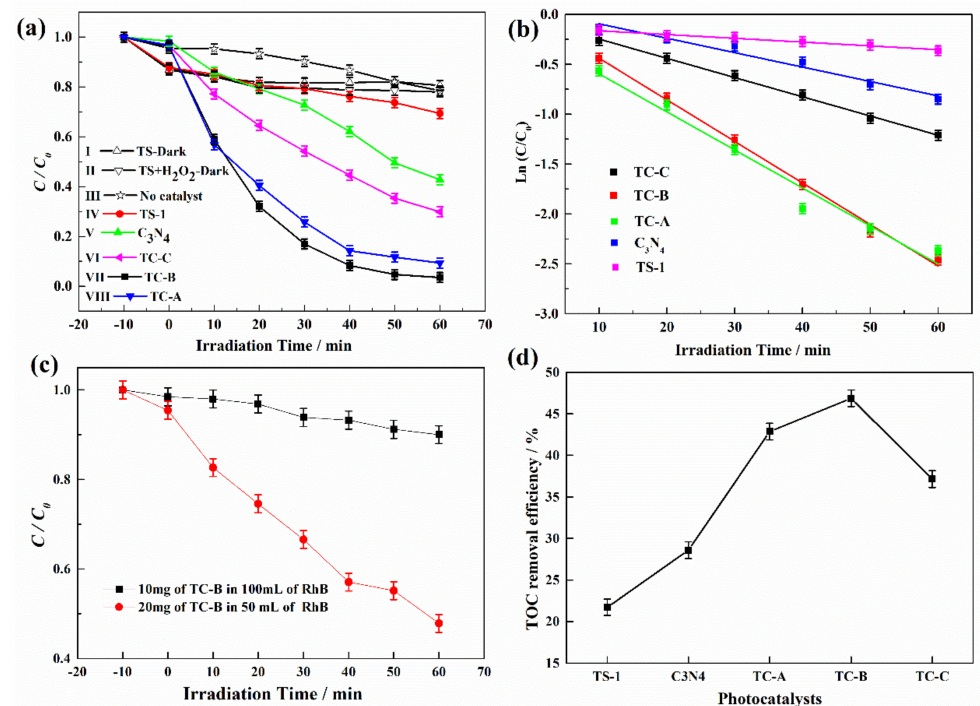
Figure 7. ( a ) Variations of RhB concentration with time. ( b ) The first-order kinetic fitting curves of RhB degradation with TS-1, C 3 N 4 , TC-A, TC-B and TC-C. ( c ) Time profiles of C / C 0 by TC-B in absence of H 2 O 2 under di ff erent conditions. ( d ) Total organic carbon (TOC) removal e ffi ciency of all photocatalysts.